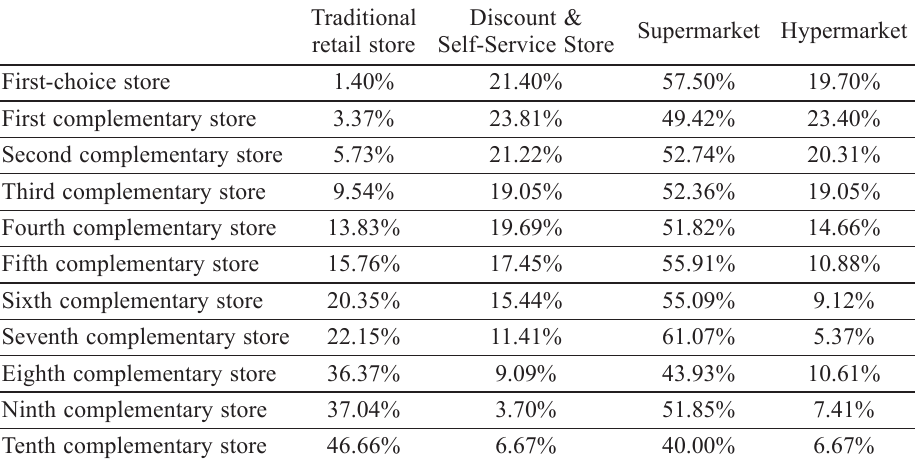
Table 3. Choice of retail format by households